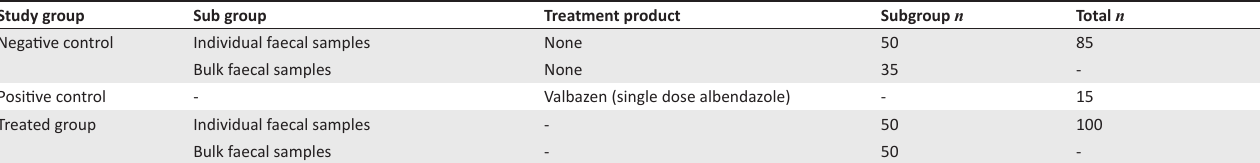
TABLE 1: Summary of the study